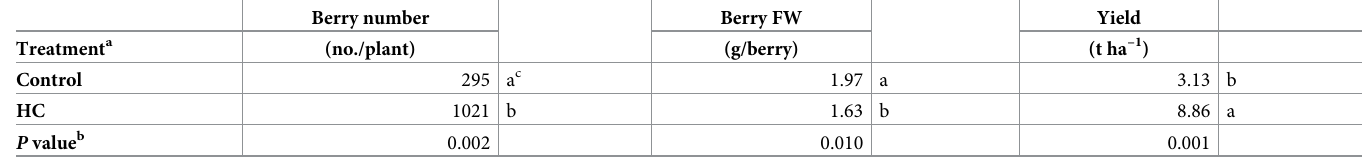
Table 2. Berry number, fresh weight (FW), and yield of ‘Emerald’ blueberry grown under inadequate chilling conditions as affected by hydrogen cyanamide (HC) in the 2019–2020 season (Expt.